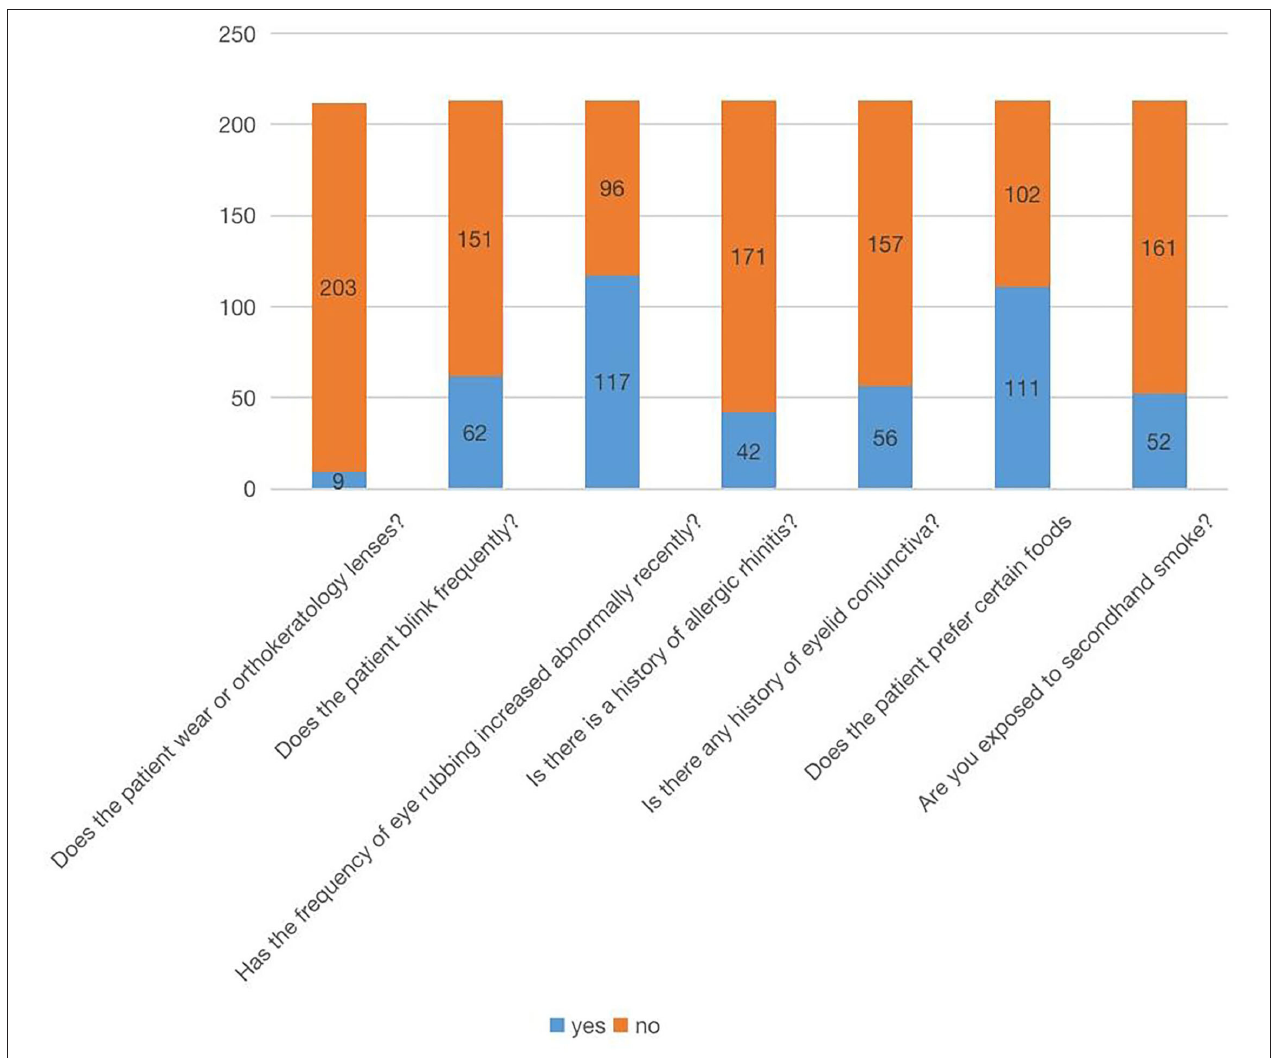
FIGURE 2 | Questionnaire content and